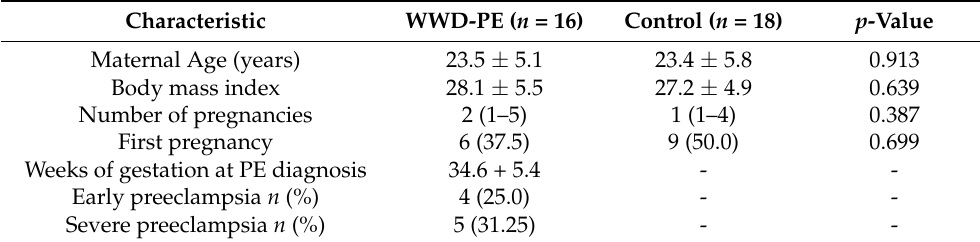
Table 1. General characteristics of the study population.